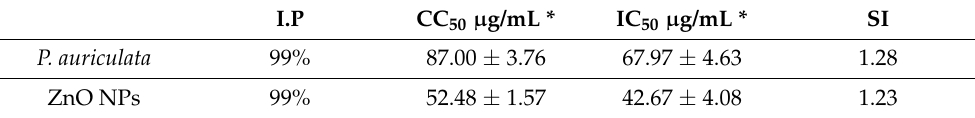
Table 2. Antiviral activity of P. auriculata extract and ZnO NPs against aMPV subtype